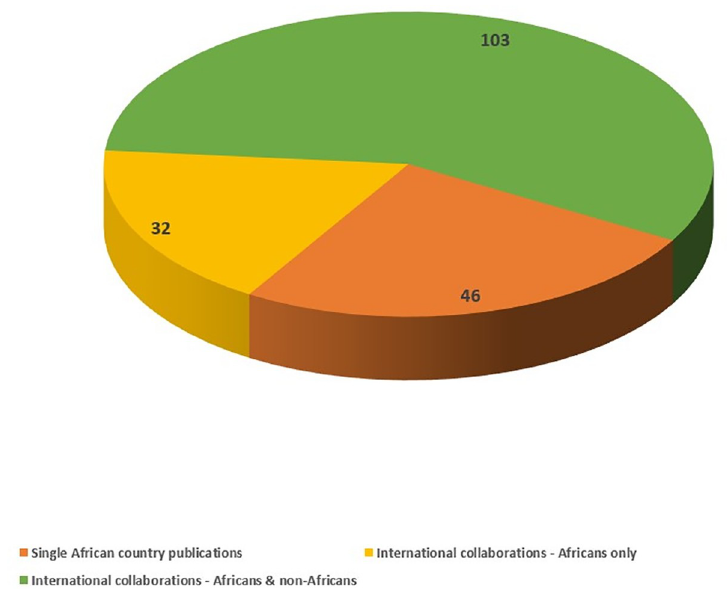
Fig 6. The number of collaborative publications between African and non-African